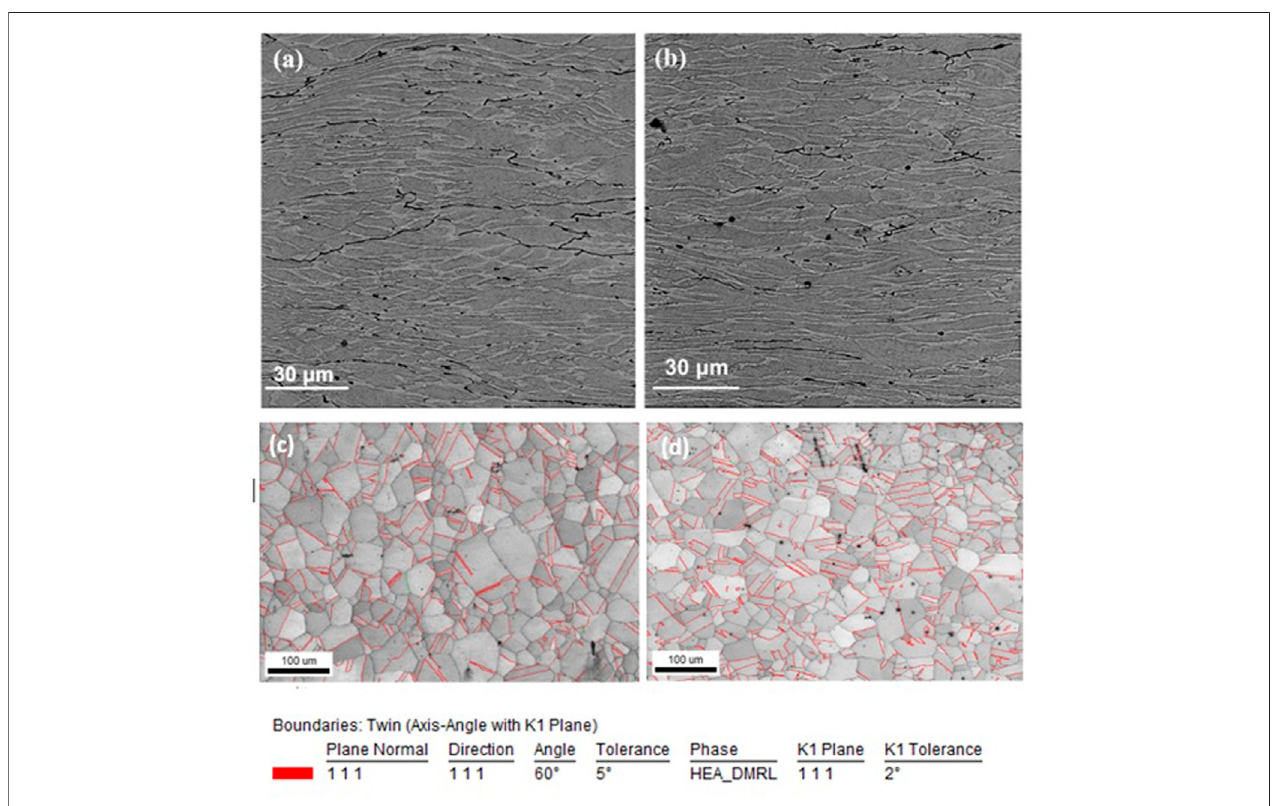
FIGURE 2 | Field-emission scanning electron microscopy (FESEM) micrographs of (A) CR1 and (B) CR2. The elongated grain structure is a signature of the cold rolling process. Equiaxed grain structure of (C) HT1 and (D) HT2. The twins present in the two microstructures as indicated by red lines were indexed to be (111) twins. These are annealing-induced